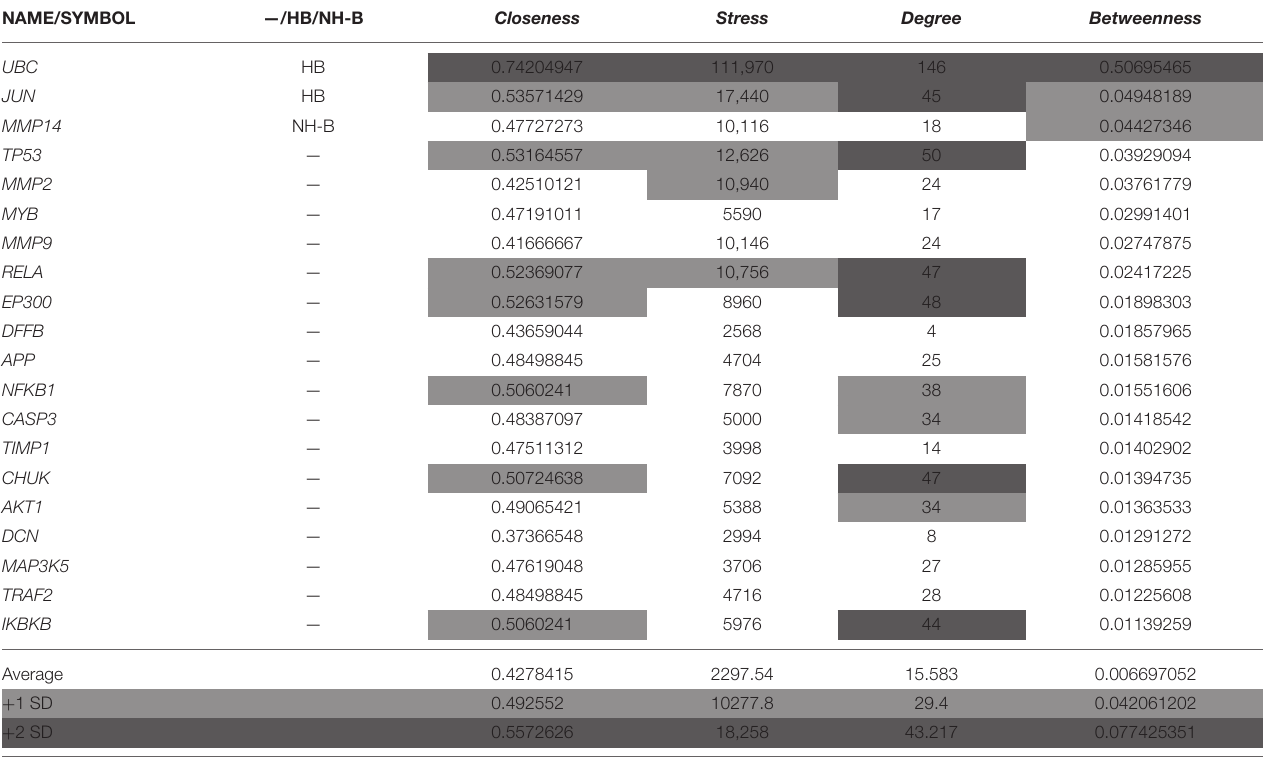
TABLE 1 | Nodes (genes/proteins) with the highest betweenness values from the “BIOMARK” interactome that integrates MMP-REDOX/NO (“MRN”) and apoptosis (“APOP”) subnetworks.